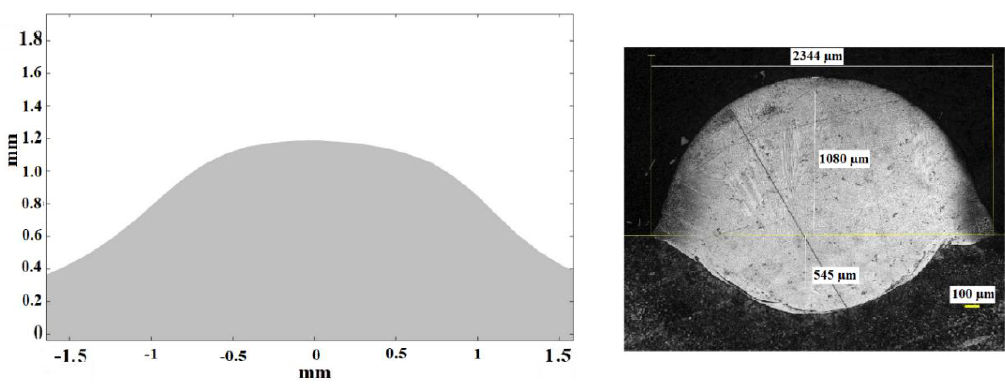
Figure 14. Theoretical ( left ) and experimental ( right ) cross sections corresponding to test